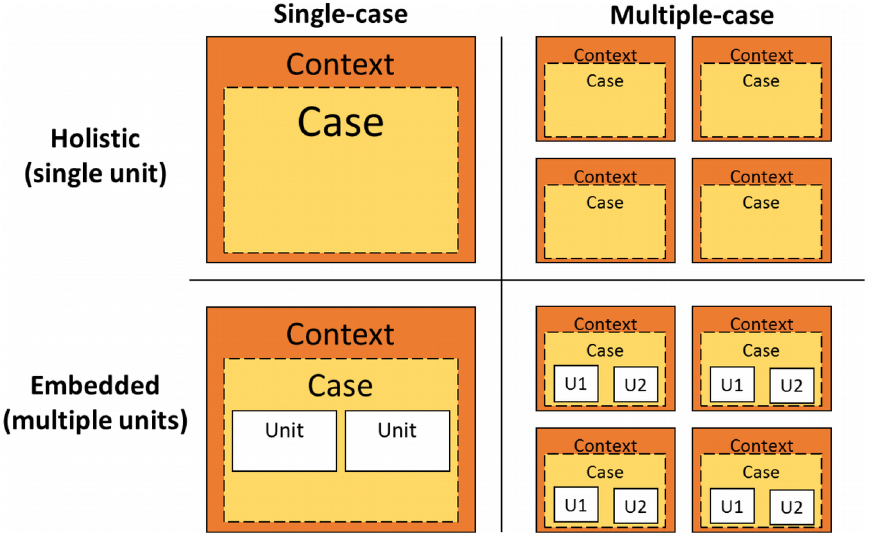
Figure 1. Case Studies (Yin,